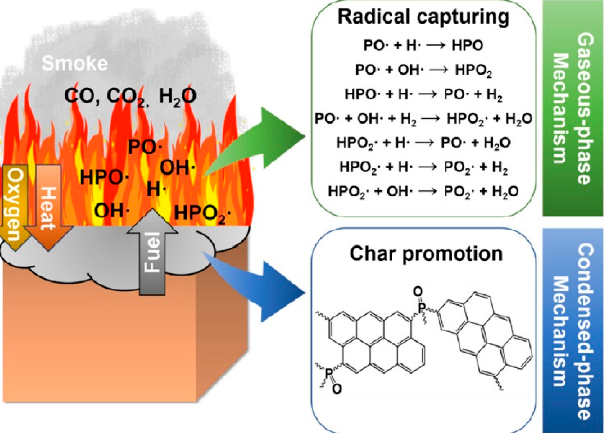
Figure 5. The flame-retardant mechanism of P-containing flame retardants: radical capturing effect in the gaseous phase and char promotion effect in the condensed phase. Reprinted with permission from Ref. [51]. Copyright 2021, Elsevier.